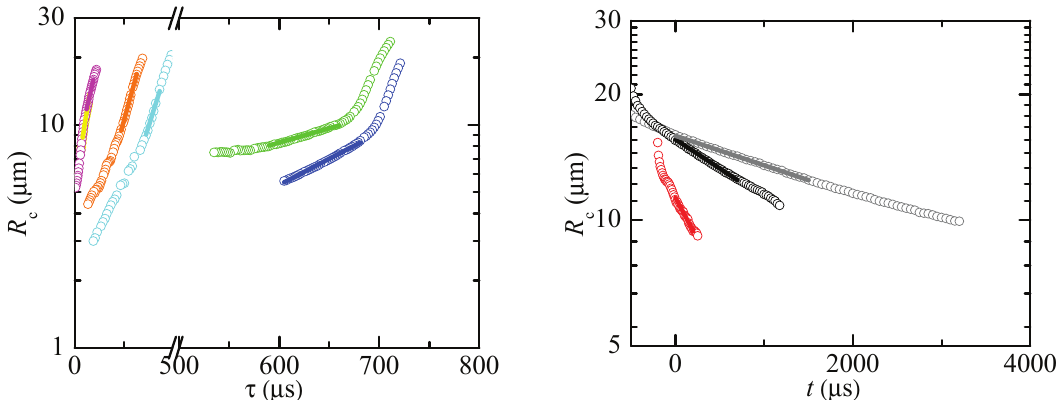
Figure 8. R c as a function of the time to pinching τ ( left ) and time t ( right ) for PEO2M-0.0003 (yellow), PEO2M-0.0005 (magenta), PEO2M-0.001 (orange), PEO2M-0.002 (cyan), PEO2M-0.004 (blue), PEO2M-0.007 (green), PEO2M-0.01 (red), PEO2M-0.03 (black) and PEO2M-0.1 (gray). The solid lines are the fits of the function (8) to the experimental